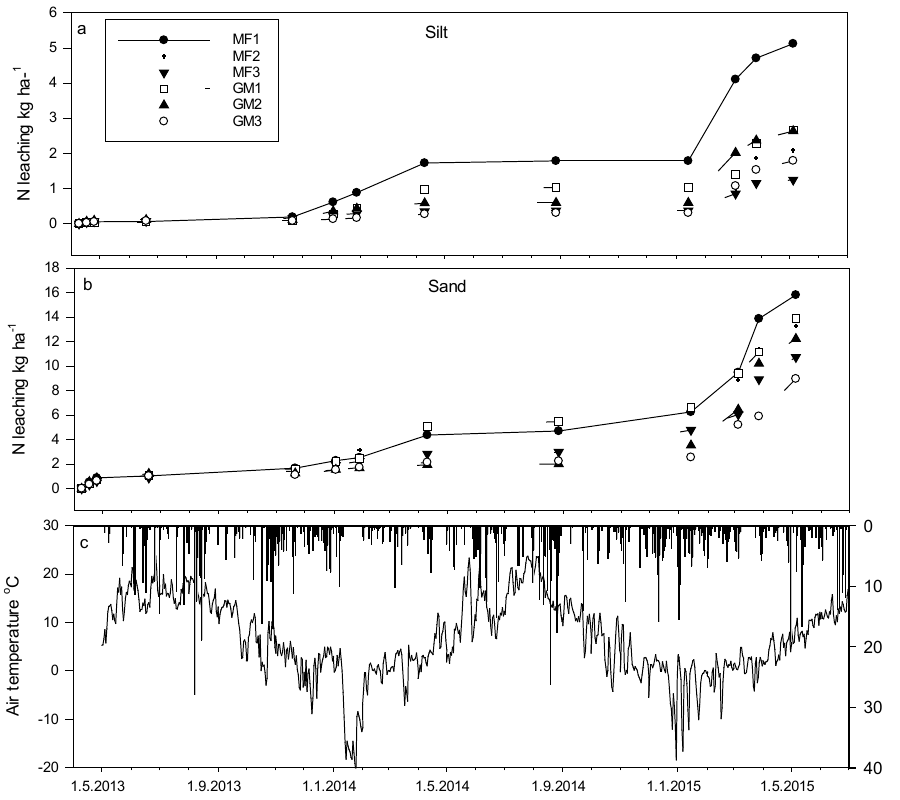
Fig. 2. Cumulative leaching of total N from different green manure or fertilizer treatments (n=4) on a) silt soil and b) sandy soil. MF1=mineral fertilizer + winter wheat, MF2=mineral fertilizer + spring wheat (straw mulching in autumn), MF3=mineral fertilizer + spring wheat (straw mulching in spring), GM1=green manure mulched in August + winter wheat, GM2=green manure mulched in October + spring wheat, GM3=green manure mulched in spring + spring wheat. Note different scales of the y-axis for the soil